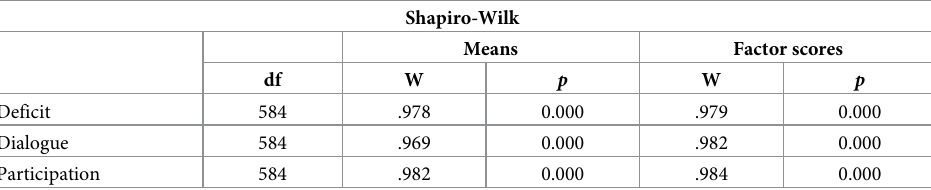
Table 3. Shapiro-Wilk tests—General science communication models.